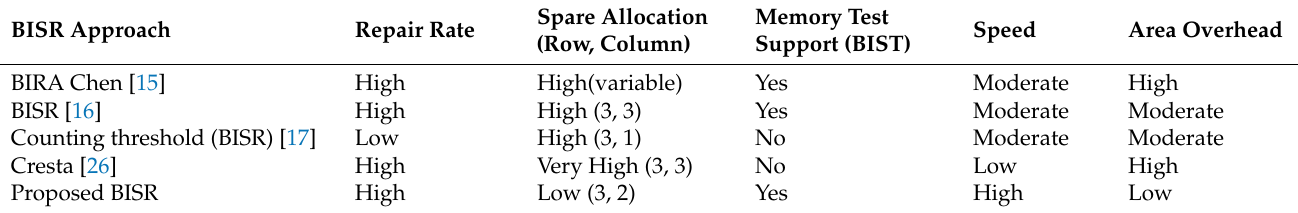
Table 12. Comparative features of different BISR approaches.